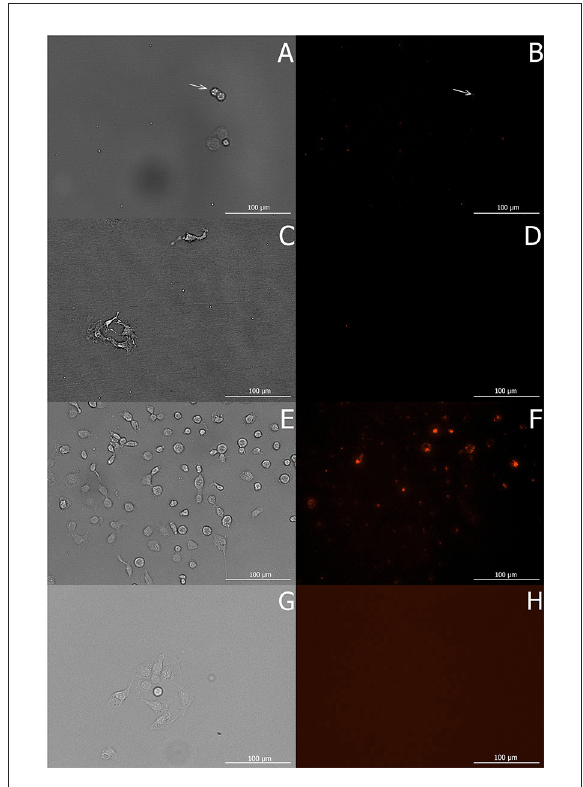
FIGURE6 Macrophage cells in vitro in Experiment 4b after 16h of phagocytic activity initiated by Red Zymosan Bioparticles at 8 ◦ C (A) , 17.5 ◦ C (C) , 37 ◦ C (E) , and phagocyted zymosan particles in these cells at the respective temperature conditions (B,D,F) visualized using Texas Red channel with a Cytation 1 microscope. At 8 ◦ C (B) , white arrows indicate the sporadic case of phagocyted zymosan particles within cells. Before application of zymosan particles, cells were preincubated for 48h at test temperatures (8, 17.5, and 37 ◦ C). Untreated control cells (G,H) were captured under the same conditions as images (A–F) .